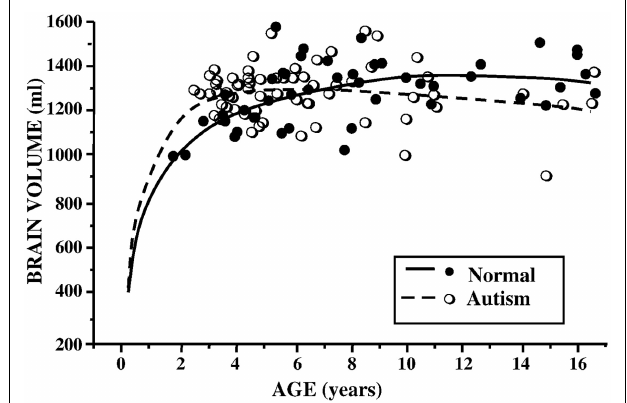
FIGURE 1 | Brain volume (milliliters) by age (years) in children with ASD and controls . Reproduced with permission from Courchesne et al. (37), adapted from Courchesne et al. (32).